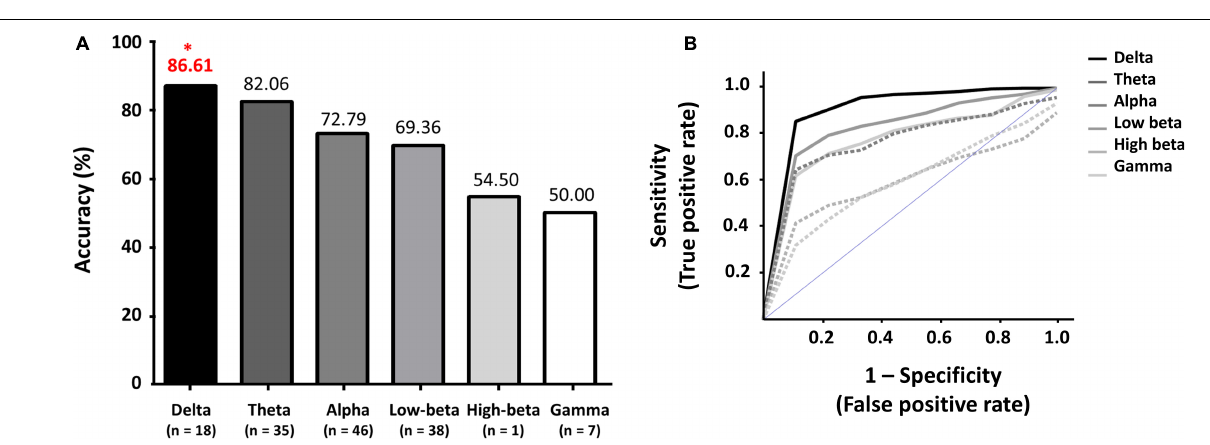
FIGURE 1 | Flowchart of machine-learning-based classification approach.